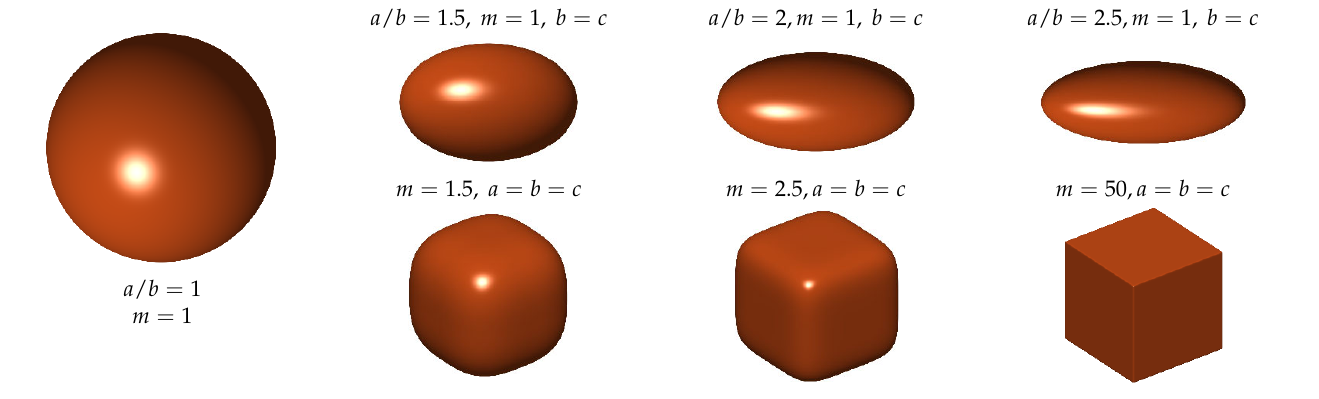
Figure 7a presents the third ‐ order approximations of thermal conductivity 𝜅 (cid:3032) using Equation (18) for different packing fractions. First, the effect of the aspect ratio is explored. It can be observed that as the packing fracture 𝜙 (cid:3028) increases, the effect of the particle